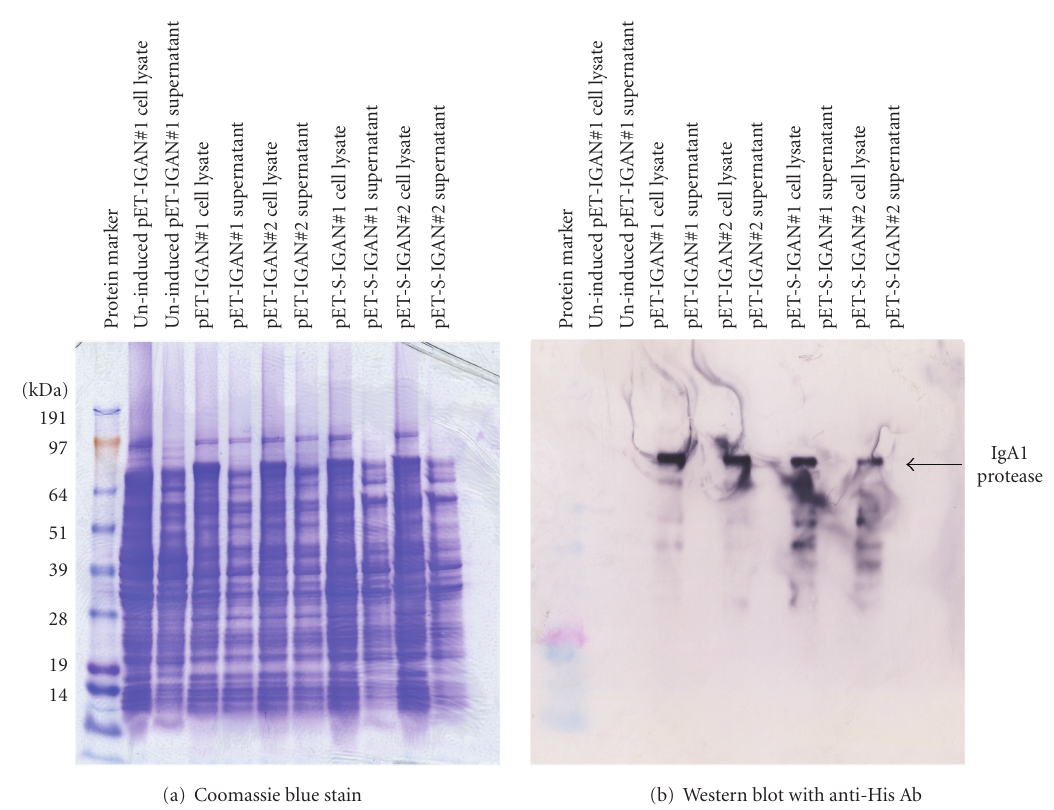
Figure 2: pET-S-IGAN and pET-IGAN IgA1 proteases were expressed in E. coli as inclusion bodies. The expressions of pET-S-IGAN and pET-IGAN were induced in BL21 (DE3) cells with 1 mM IPTG at 30 ◦ C for 3 hours. The total cell lysates and soluble supernatants were analyzed with SDS-PAGE (reduced condition) and Western